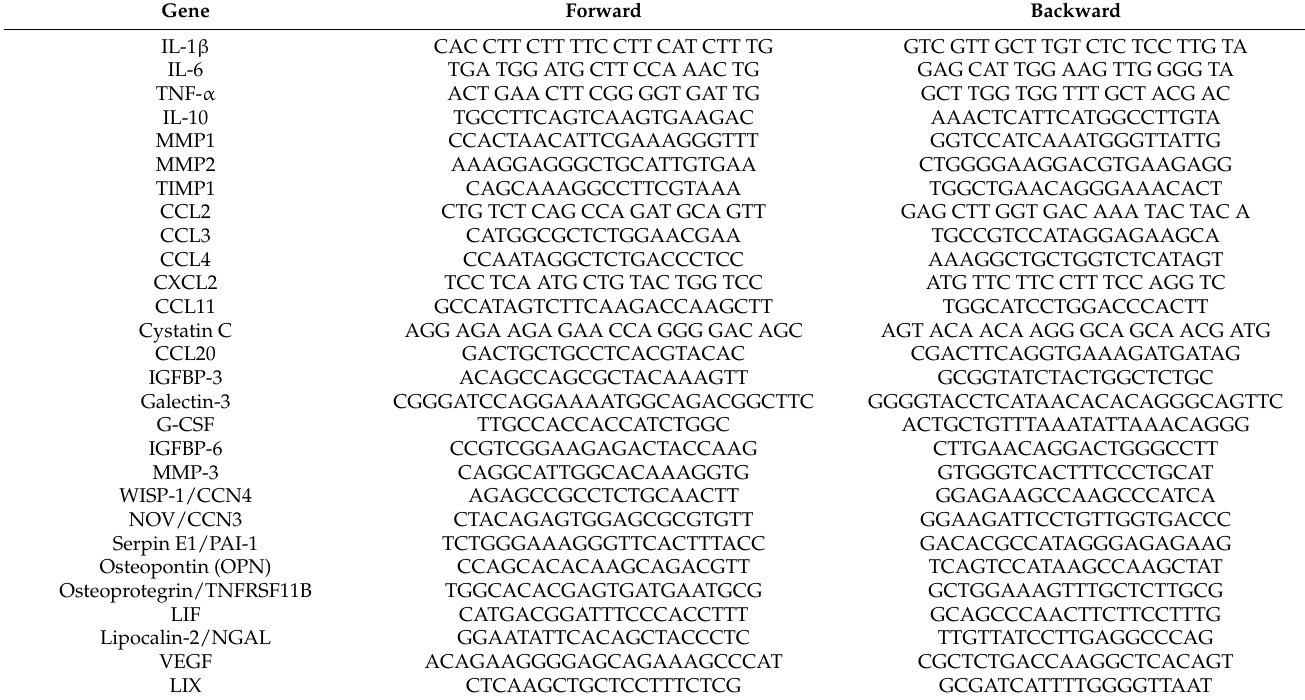
Table 2. The primers used in